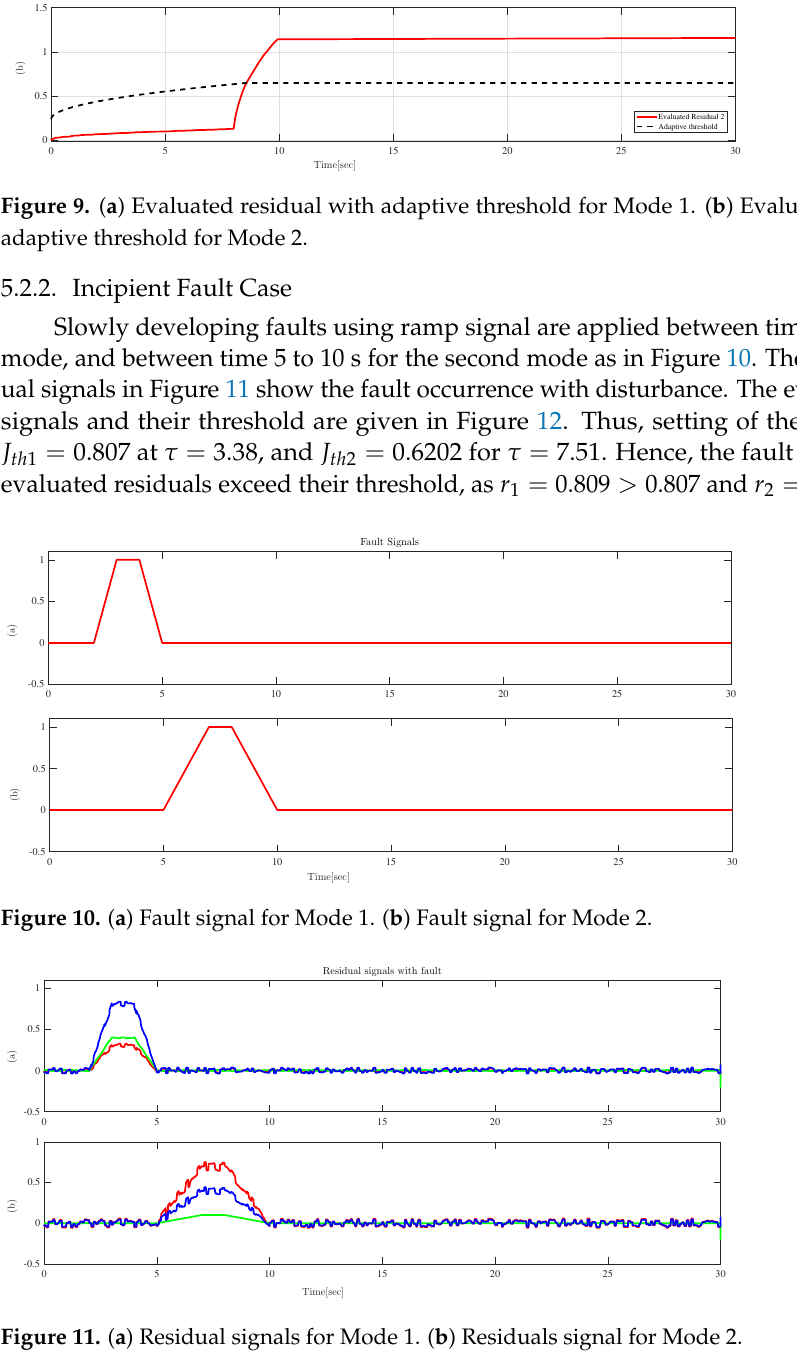
Figure 11. ( a ) Residual signals for Mode 1. ( b ) Residuals signal for Mode